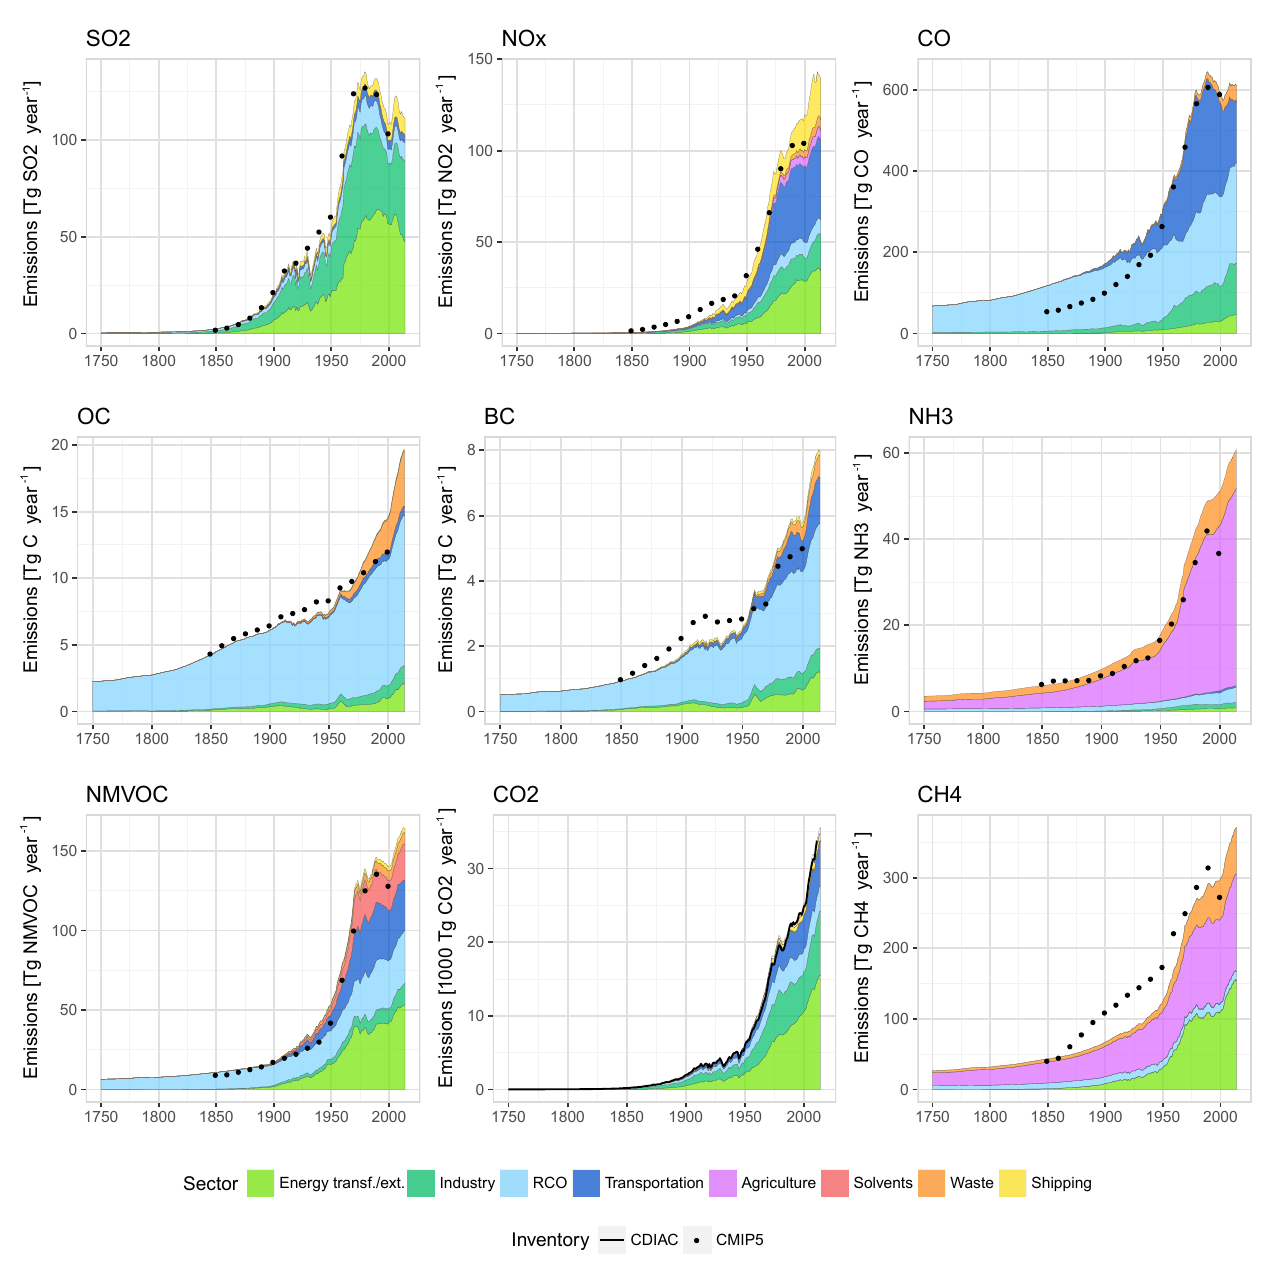
Figure 2. CEDS emission estimates by aggregate sector compared to Lamarque et al. (2010) (dots) and CDIAC (line) for CO 2 . For a like- with-like comparison, these figures do not include aviation or agricultural waste burning on fields. “RCO” stands for residential, commercial, and